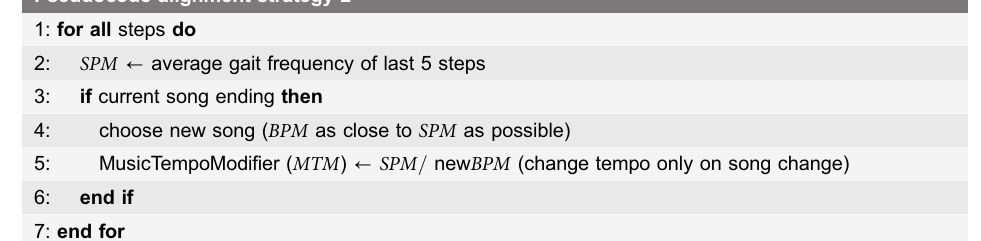
Table 3. Algorithm 2. Pseudocode alignment strategy